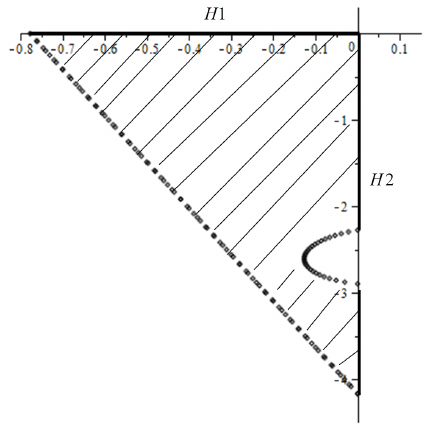
Figure 2. Stability region of the proposed direct block method of order six (2PDD6)